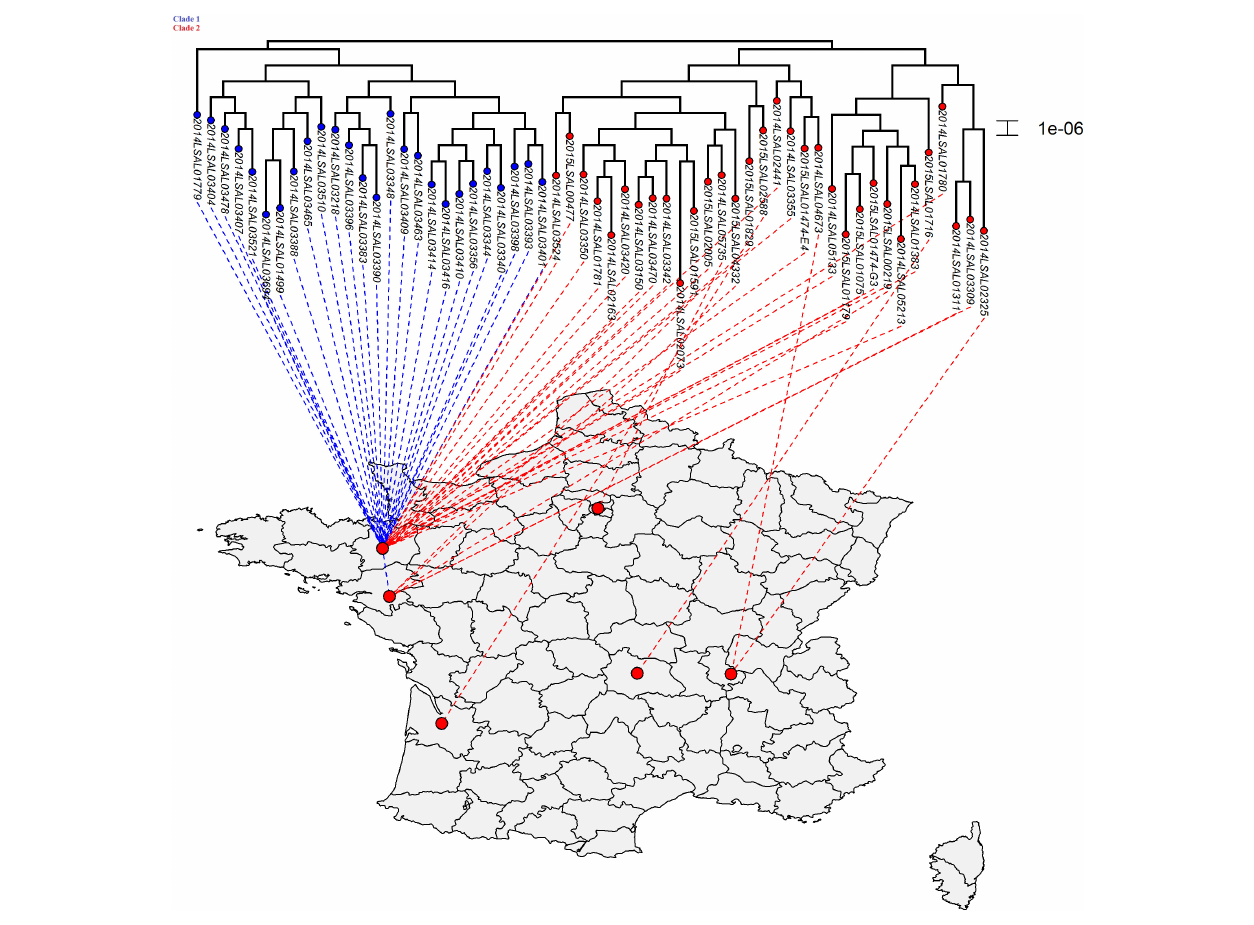
FIGURE 3 | Phylogenetic SNP distribution of the strains from the cluster ST71 in relation with their geographical repartition. Tree is constructed under the maximum likelihood criterion using the GTR-gamma model. The scale bar indicates the number of substitutions per site. Two distinct clades were identified. The strains belonging to Clade 1 were principally isolated in Brittany (25/26